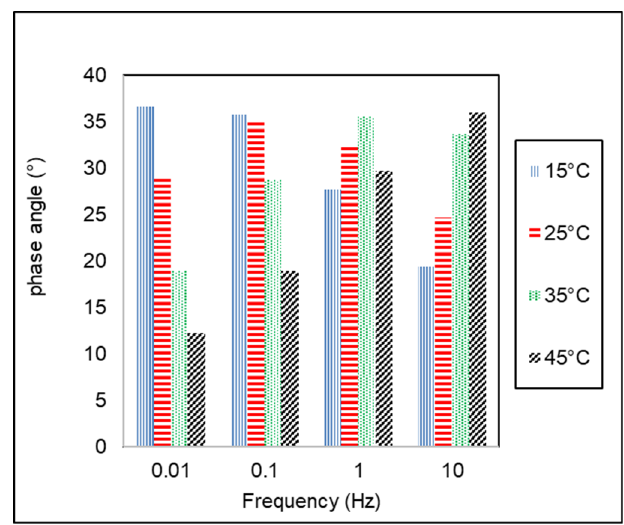
Figure 8. Variation of phase angle of AC-WC with temperature and frequency.